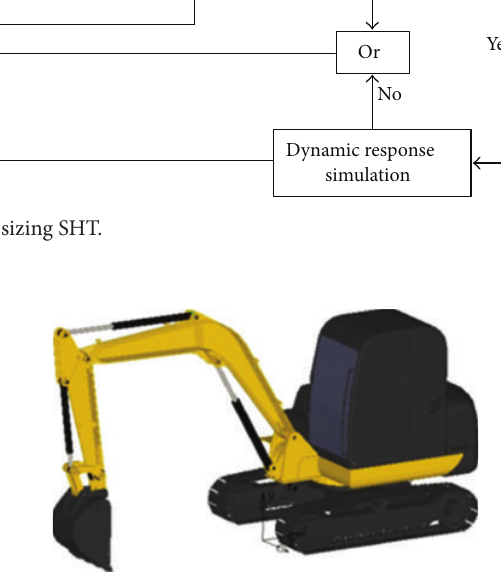
Figure 5: Mechanical model of